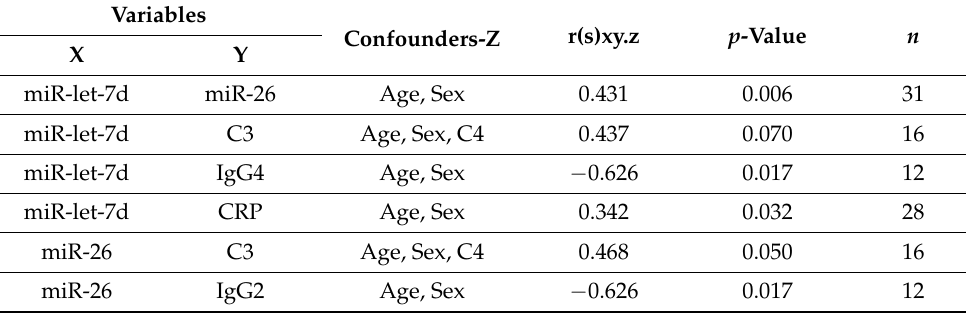
Table 3. Correlation tests between miRNA levels and IgG and C3/4